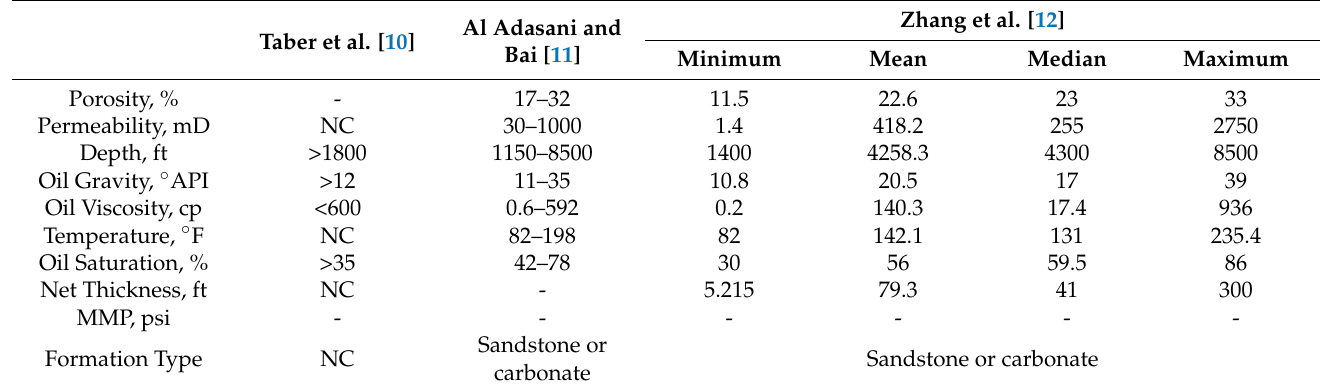
Table 2. Existing screening criteria for immiscible CO 2